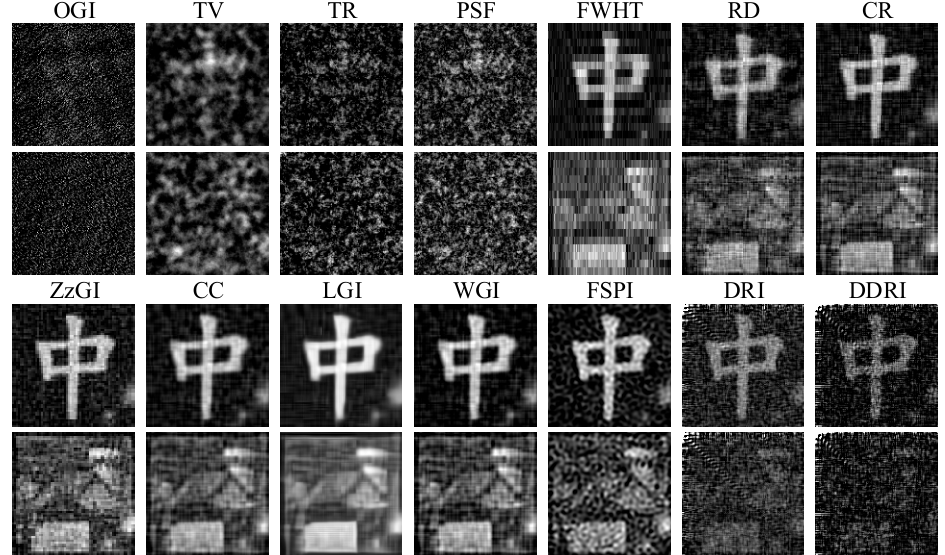
Figure 9. Experimental results of fourteen GI methods in the general environment (without WT). Figure 12. Experimental results of fourteen GI methods in the underwater environment (with WT, with turbulence). Table 8. PSNR and RMSE of images corresponding to the object “ 中 ” in Figure 12.